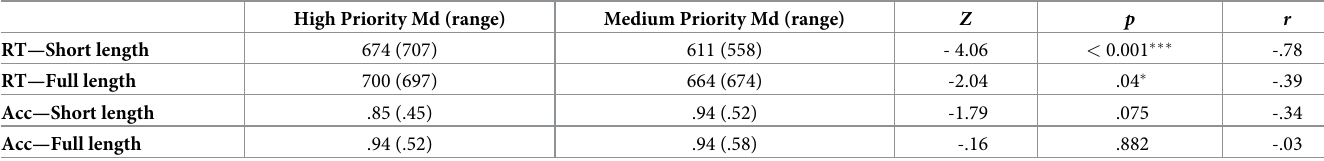
Table 2. RT and accuracy behavioural data by condition (short length and full